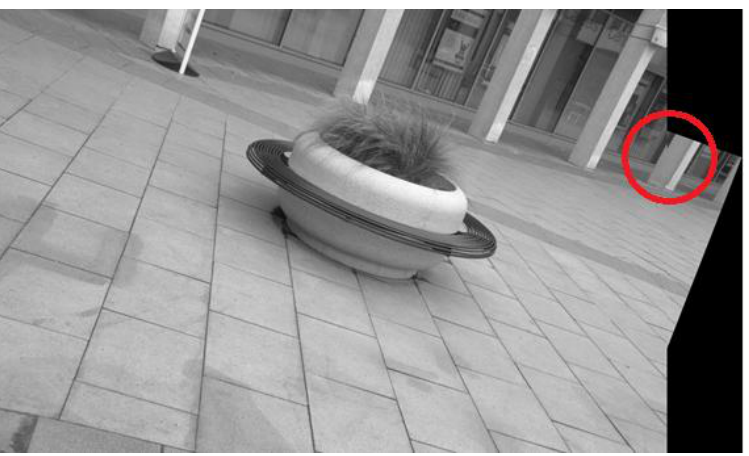
Figure 16. Image registration result for the image pair 4 of the database using IBR alone; the region inside the red circle indicates that better registration is required.